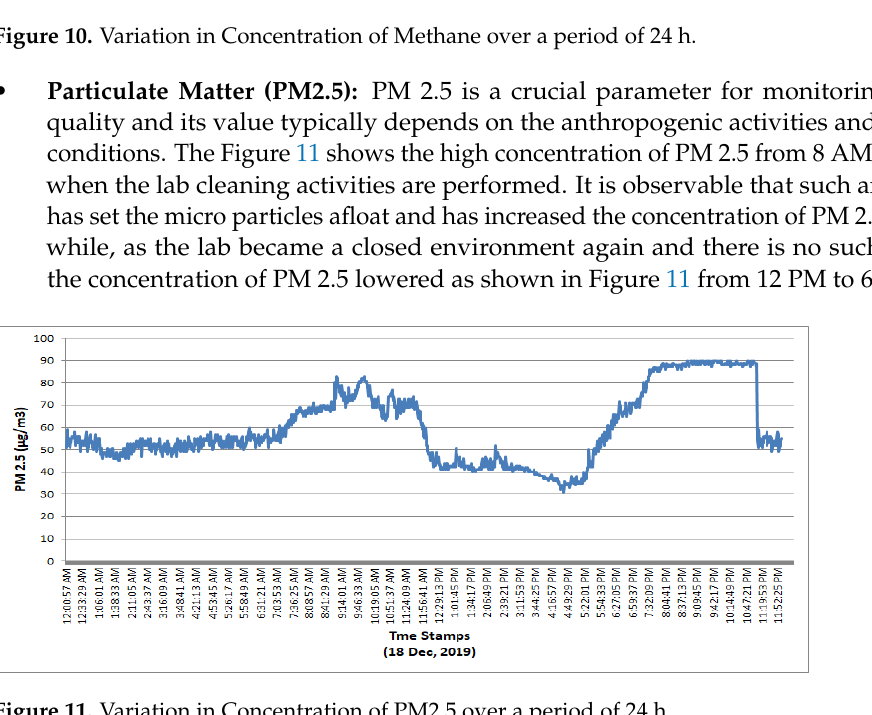
Figure 11. Variation in Concentration of PM2.5 over a period of 24